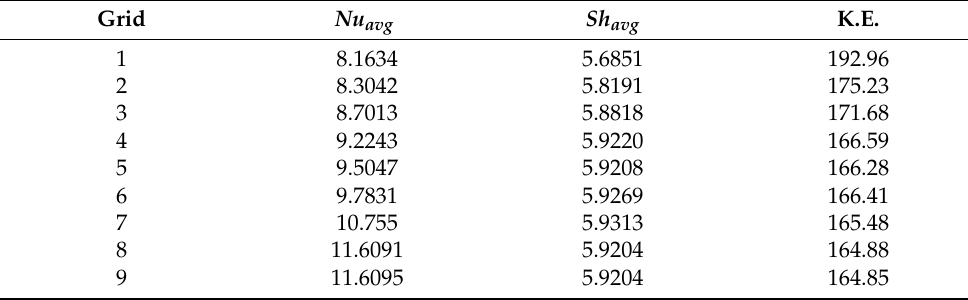
Table 2. Study of grid convergence for average mass and heat